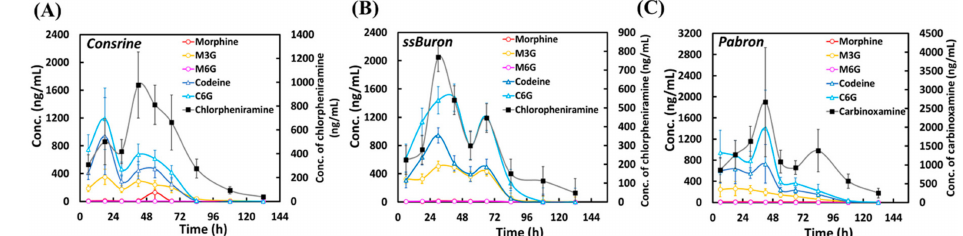
Figure 1. Clinical average concentrations of opiate, opiate metabolites, and antihistamines (chlorpheniramine or carbinoxamine) in the urine samples of the ten participants collecting from